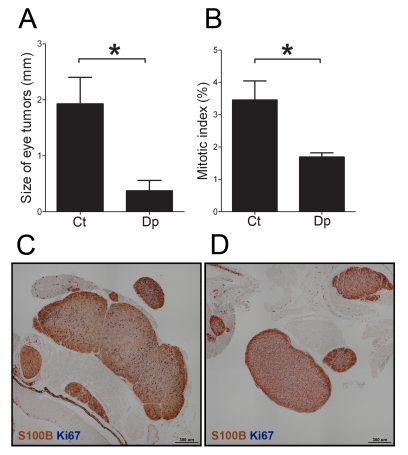
PMN-MDSC favor tumor cell proliferation in the primary tumor.(A) Five-week-old mice were depleted of PMN-MDSC by bi-weekly injection of anti-Ly6G antibody (NIMP-R14) (depletion scheme B). At 20 wk of age, mice were euthanized and the size of the primary tumors was measured. Results are from a total of 22 tumors derived from four depleted mice (Dp) and seven littermates injected with a control antibody (Ct). (B–D) One-week-old mice were depleted of PMN-MDSC by bi-weekly injection of anti-Ly6G antibody (depletion scheme A). At 7 wk of age, mice were culled and eye tumors were analyzed by two-color immunohistochemistry using S100B- (brown) and Ki67- (blue) specific antibodies. (B) Comparison of the mitotic indices measured in 172 nodules taken from eight depleted mice (Dp) and 130 nodules from seven control littermates (Ct). Panels C and D show representative examples of tumors from control and depleted mice. Bars in panels A and B represent mean ± SEM. *p value <0.05, two-tailed unpaired Student’s t test.